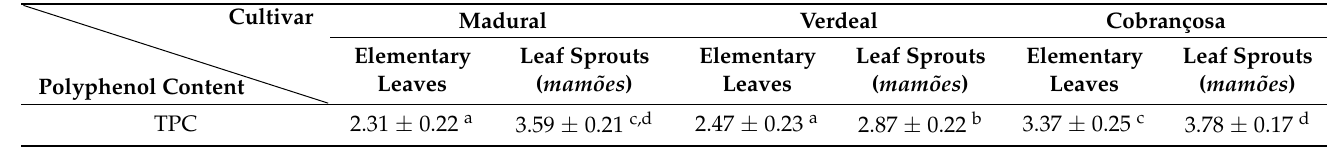
Table 2. Total phenolic compounds of different varieties of olive leaves.